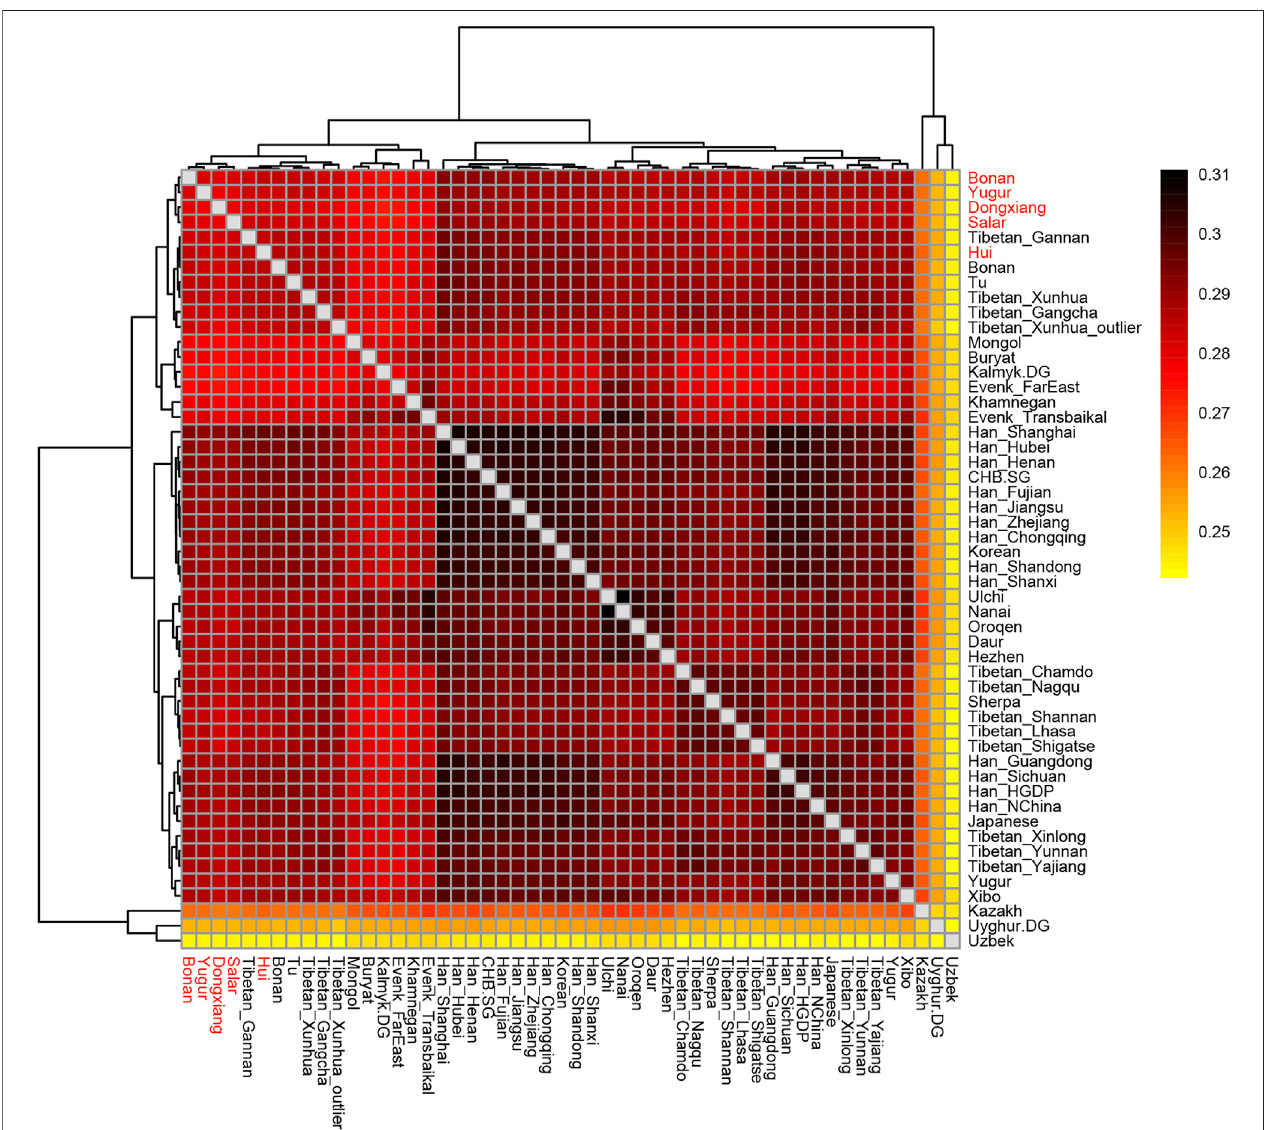
FIGURE 7 | Heatmap results of the outgroup- f 3 statistics of the form f 3 (X, Y; Mbuti). The larger values indicated that they shared more genetic drifts. Here the Outgroup was Mbuti.